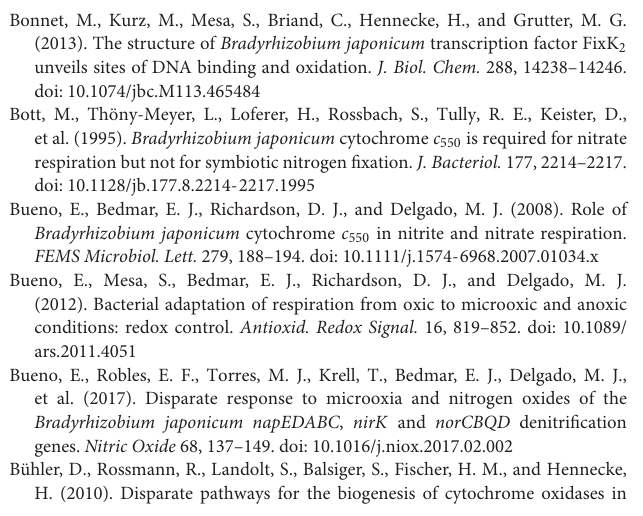
TABLE S1 | Strains and plasmids used in this study. TABLE S2 | Oligonucleotides used in this study. TABLE S3 | List of the 175 genes induced under anoxic denitrifying conditions and at the same time their expression is downregulated in the nnrR mutant in comparison to the WT, both cultivated in anoxic denitrifying conditions. DATA SHEET S1 | References cited in the Supplementary Material